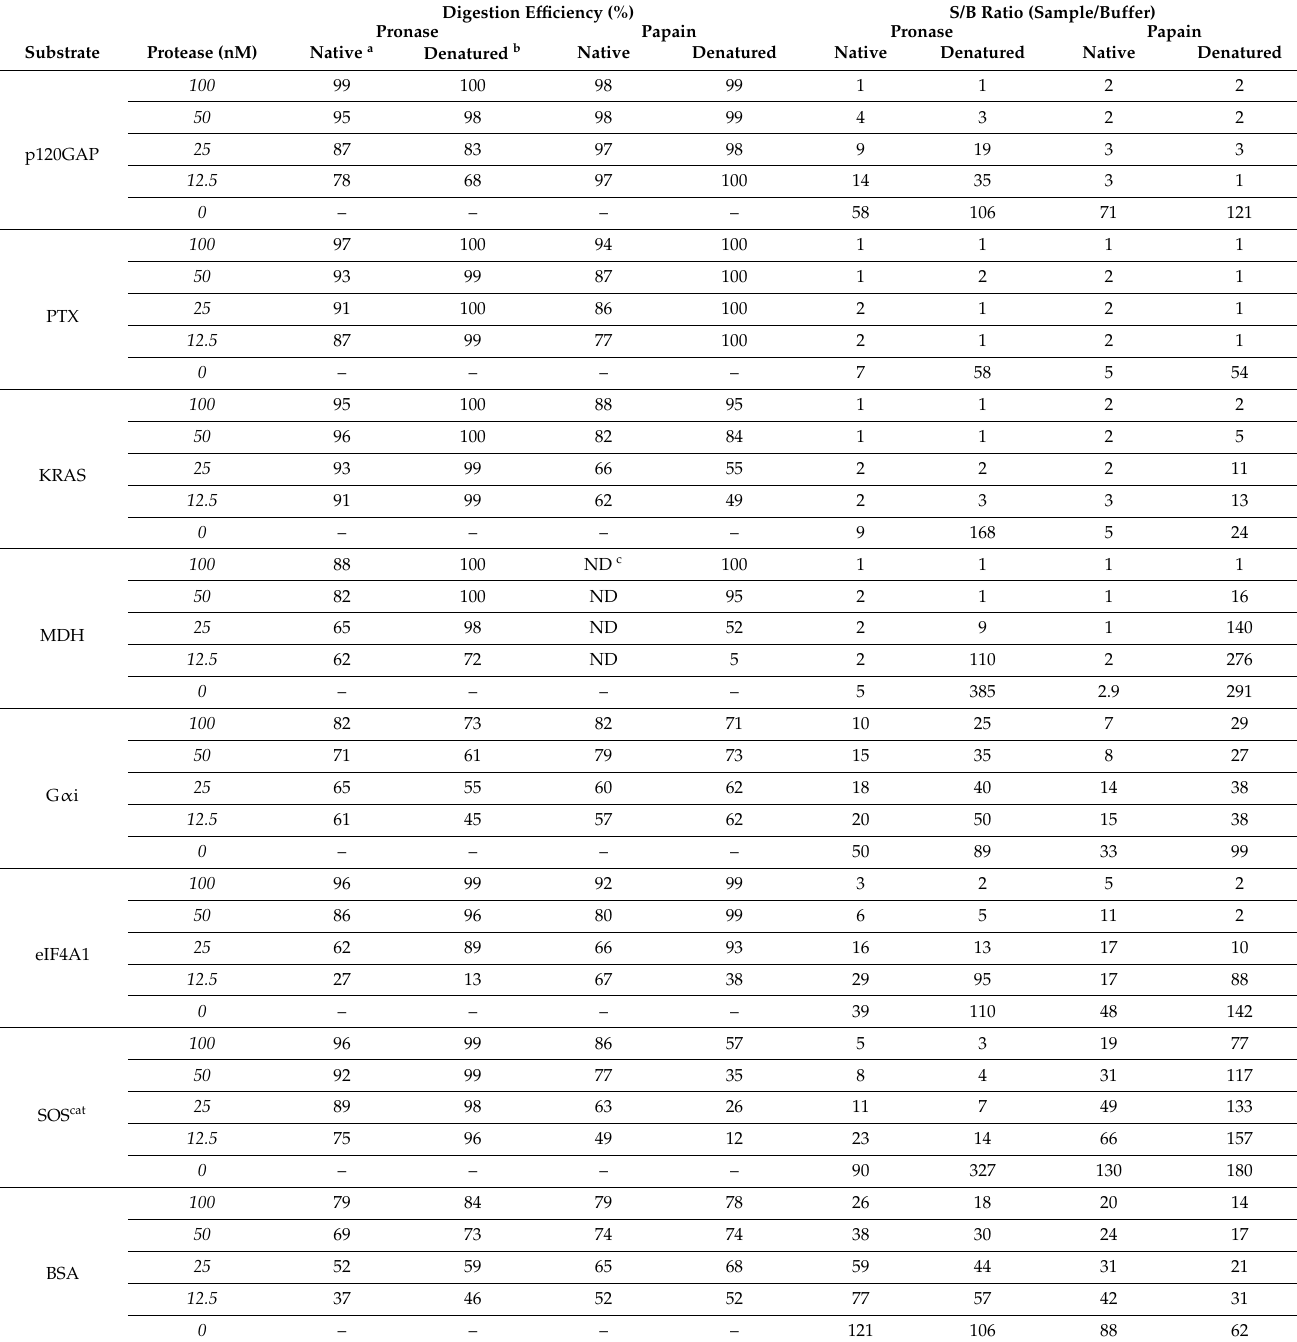
Table 2. Digestion efficiency (%) of papain and pronase at different concentrations with variety of native substrates monitored with the